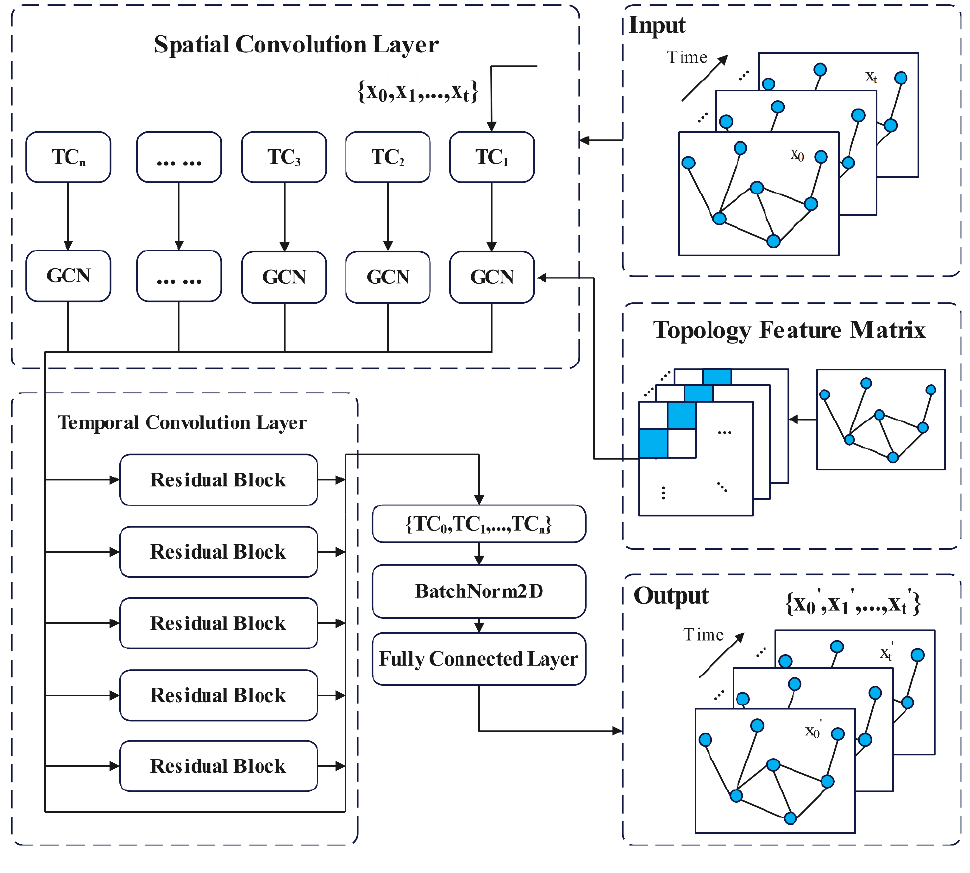
Figure 9. Structure of the GSTNCNI.